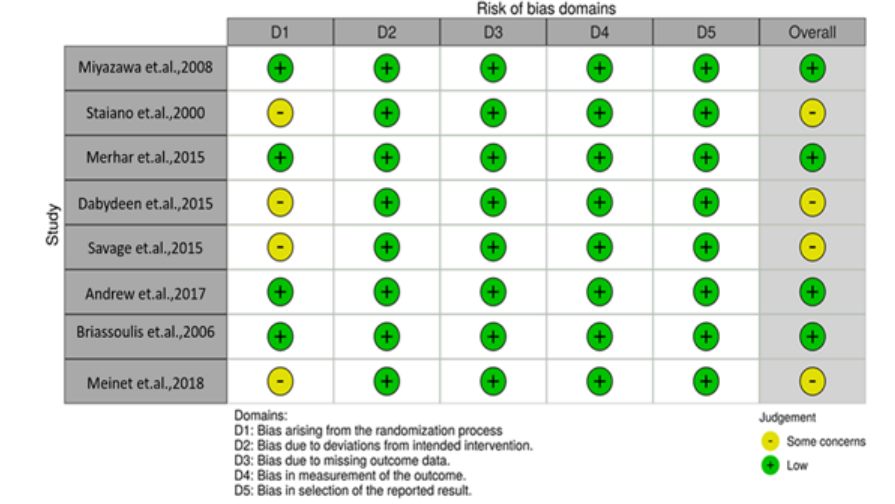
Figure 2. Risk of Bias of randomized clinical trials included in the study.